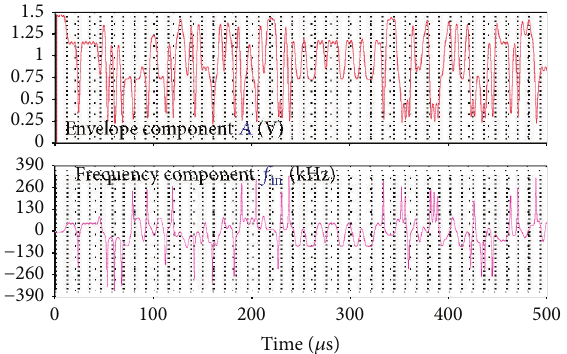
Figure 5: Simulated envelope and frequency components for EDGE signal.